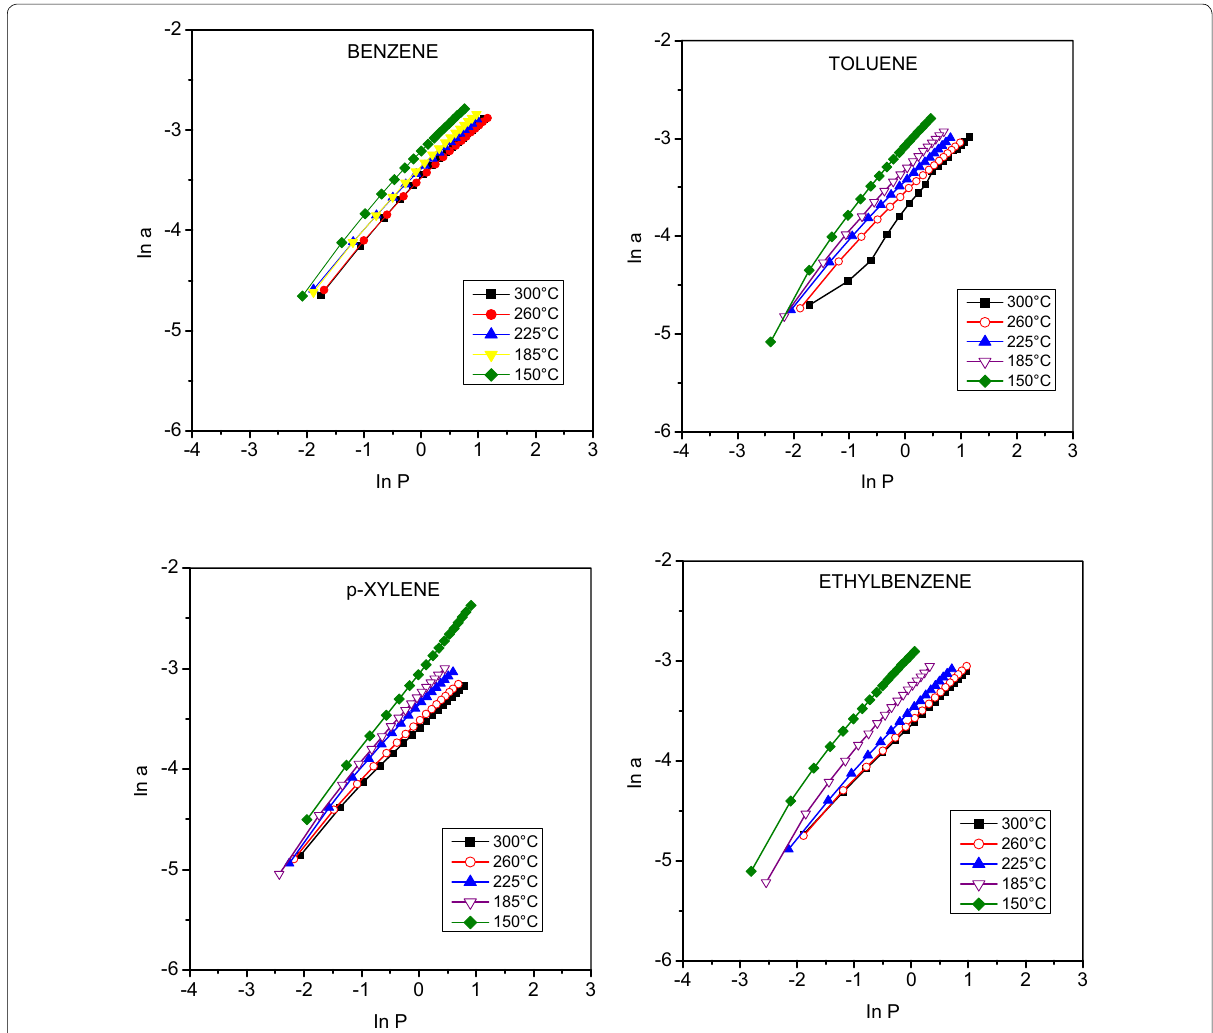
Fig. 8 Benzene, toluene, p ‑xylene, and ethylbenzene adsorption isotherms with the Freundlich model for SBA‑15/HT